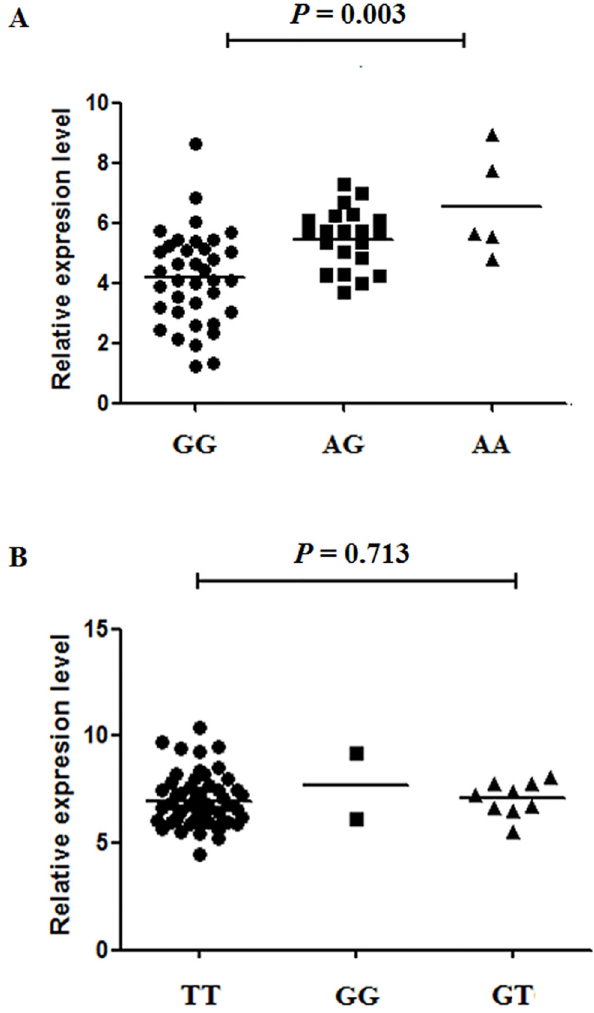
Fig 1. Expression of Cav-1 in cancer adjacent normal renal tissues. (A), Samples with rs1049334 AG or AA genotypes were associated with higher expression levels of Cav-1 mRNA compared with samples with GG genotypes in normal tissues of ccRCC patients ( P = 0.003). (B), No significant differences in ROCK1 expression among different ROCK1 rs35996865 genotypes were observed ( P =